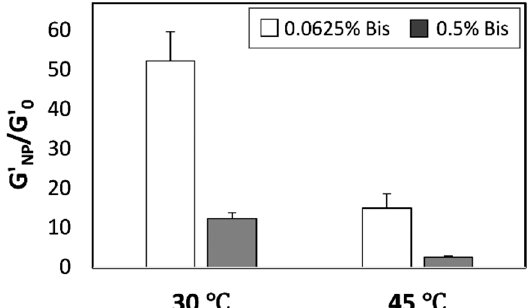
Figure 5. Relative elastic moduli of 5% pNIPAAm hydrogels prepared using 0.0625% Bis (white bars) or 0.5% Bis (grey bars), and 5% SiNPs at different temperatures. Data shown are the mean of triplicate measurements plus standard deviation and have been repeated at least three times with similar results.